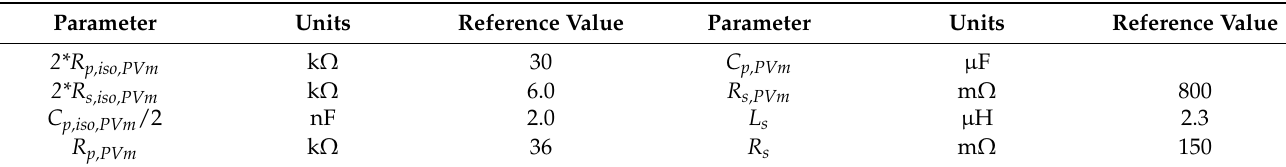
Table 3. Value setting adopted for parameters in the reference case (irradiation: 100 W/m 2 ; frequency: 1 MHz; high PV module insulation; MMP